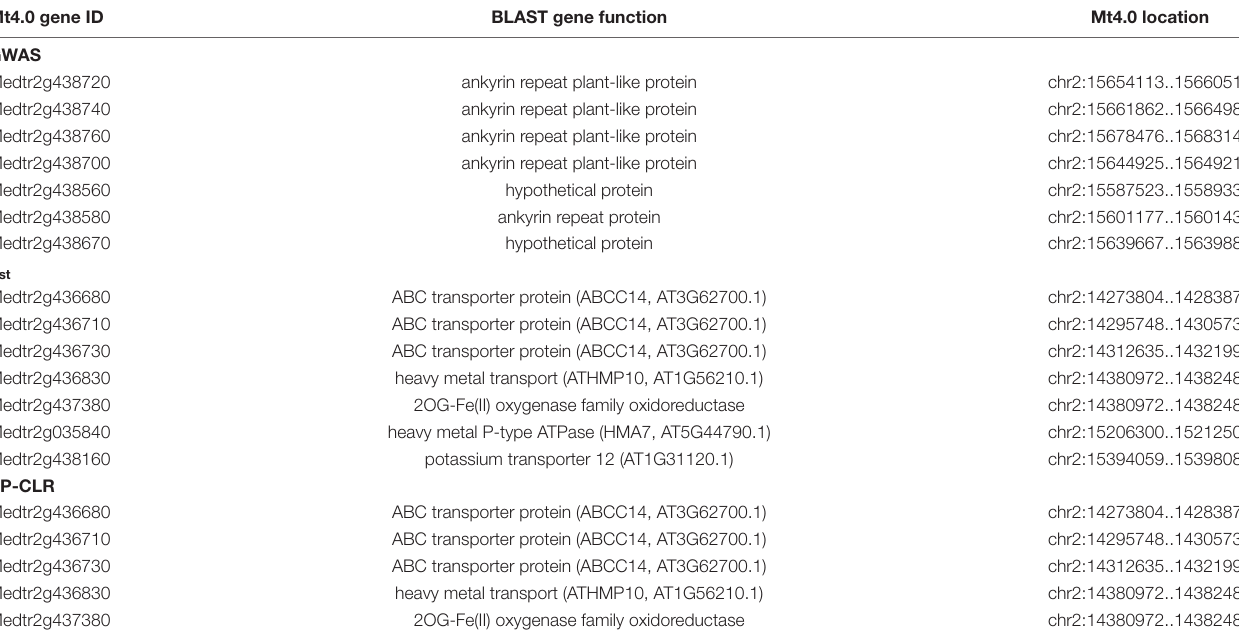
TABLE 2 | Genes in chromosome 2 genomic regions associated with Cd relative root growth (Cd RRG) that were identified using GWAS, F st and XP-CLR. Mt4.0 gene ID